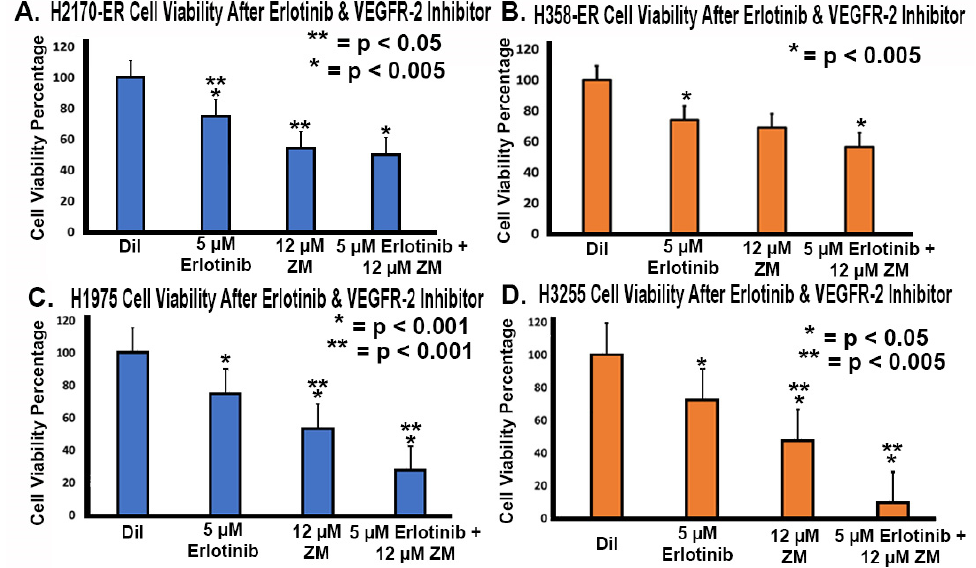
Figure 7. Effect of anti-VEGFR-2 treatments in resistant and mutated NSCLC cell lines. A total of 8000 H2170-ER, H358-ER, H1975, and H3255 NSCLC cells were treated with diluent (control), 5 µ